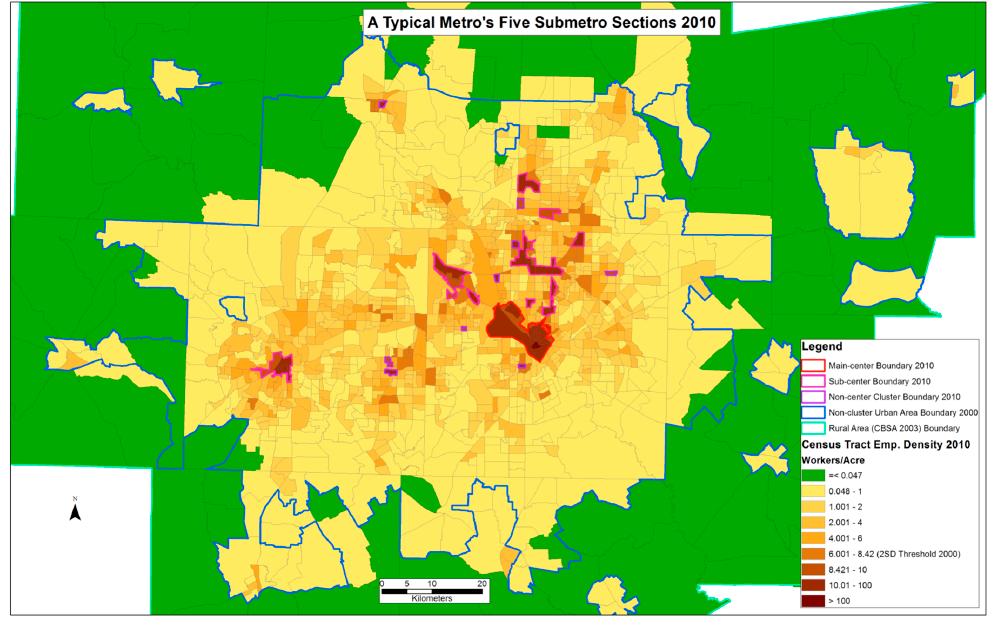
Figure 3. A typical metro’s (Dallas–Fort Worth–Arlington, TX) five submetro sections in 2010.